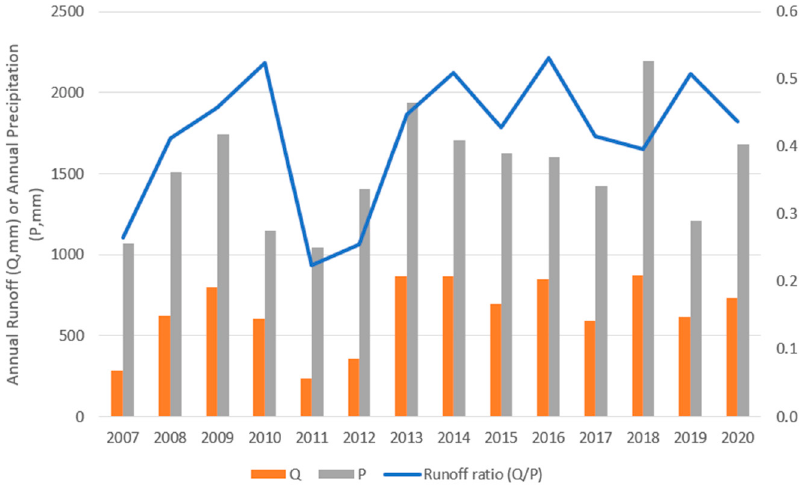
Figure 6. Total annual runoff and precipitation and runoff-rainfall ratio for the Chipola River watershed 2007–2020.